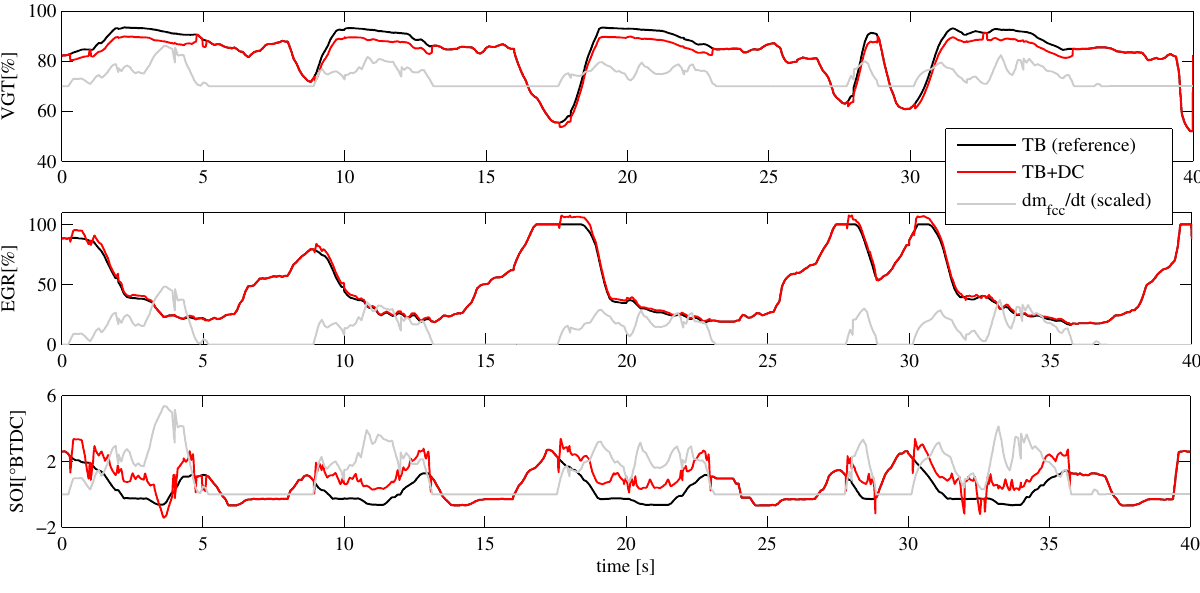
is the volume of fuel fcc